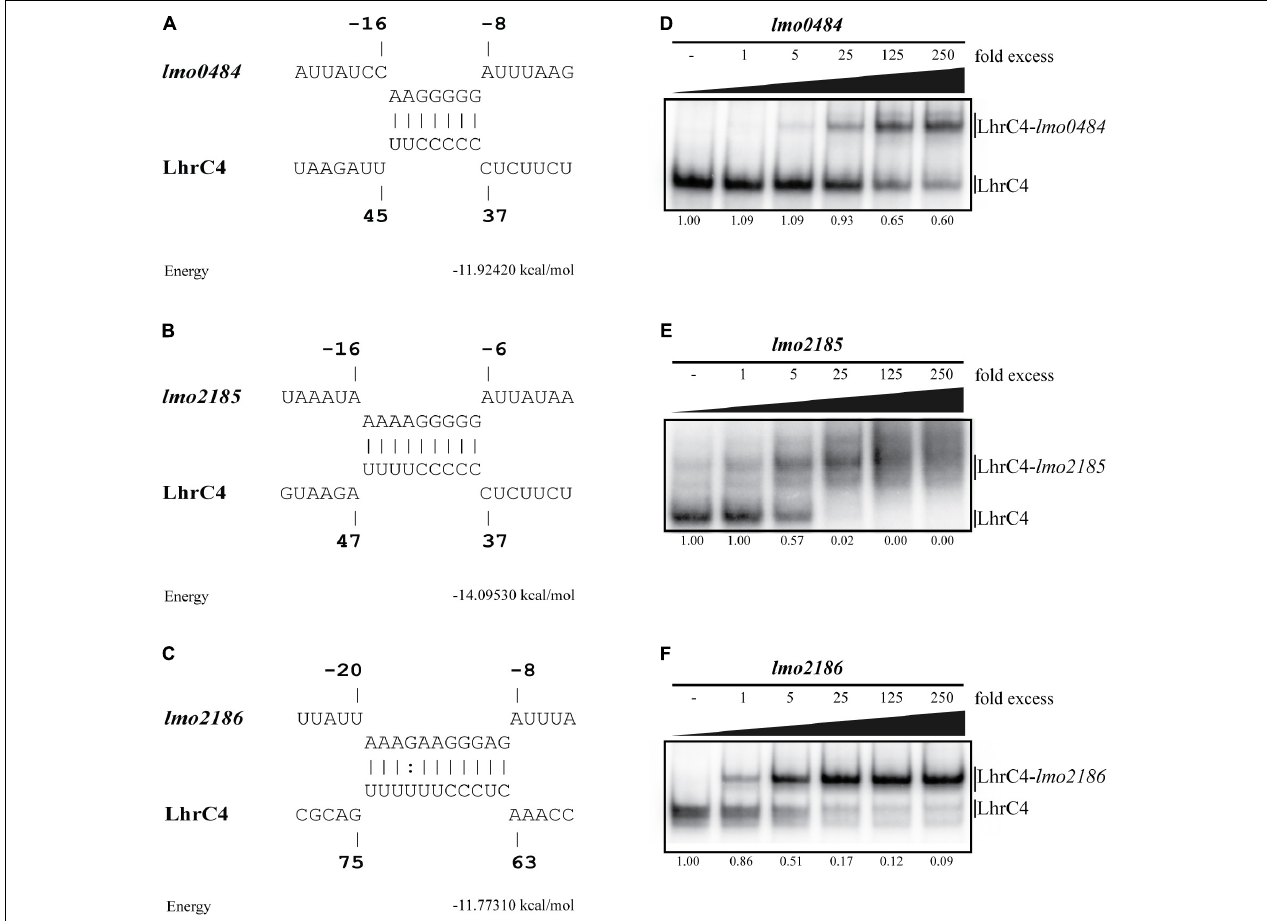
FIGURE 4 | Analyzing the sRNA-mRNA interaction between LhrC4 and lmo0484 , lmo2185, or lmo2186 . (A–C) In silico prediction of sRNA-mRNA interactions. According to the IntaRNA Software (Busch et al., 2008; Wright et al., 2014; Mann et al., 2017), the loop A of LhrC4 binds to (A) lmo0484 and (B) lmo2185 mRNAs, and the single-stranded stretch binds to (C) lmo2186 mRNA. All the interactions are predicted to block the SD sequence of the mRNAs. LhrC4 is shown as a representative of the five LhrC copies. The nucleotides of lmo0484 , lmo2185, and lmo2186 are numbered relative to the translation start site, and the nucleotides of LhrC4 are numbered relative to the 5 (cid:48) -end of the sRNA. (D–F) Testing the formation of sRNA-mRNA complexes by EMSAs. Labeled LhrC4 was shifted with increasing concentrations of unlabeled (D) lmo0484 RNA, (E) lmo2185 RNA or (F) lmo2186 RNA. Fold excess refers to the amount of unlabeled mRNA added to each sample, relative to the amount of labeled LhrC4. The fraction of unbound LhrC4 is shown below each